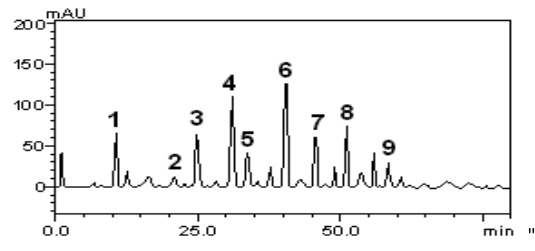
Fig. 4: Representative high performance liquid chromatography profile of Olea europaea extract, detection Uv was at 327 nm. Gallic acid (peak 1), chlorogenic acid (peak 2), caffeic acid (peak 3), ellagic acid (peak 4), epicatechin (peak 5), rutin (peak 6), quercitrin (peak 7), quercetin (peak 8) and kaempferol (peak 9). Tab. 2: Phenolics and flavonoids composition of Olea europaea